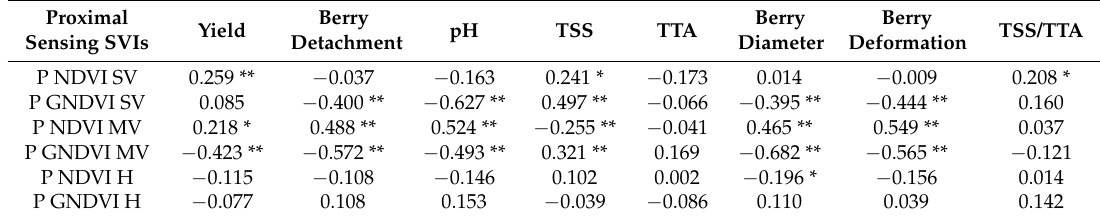
Table 7. Pearson’s correlation matrix between the proximal-based spectral vegetation indices and the table grape yield and quality characteristics at different crop stages. Proximal Yield Sensing SVIs